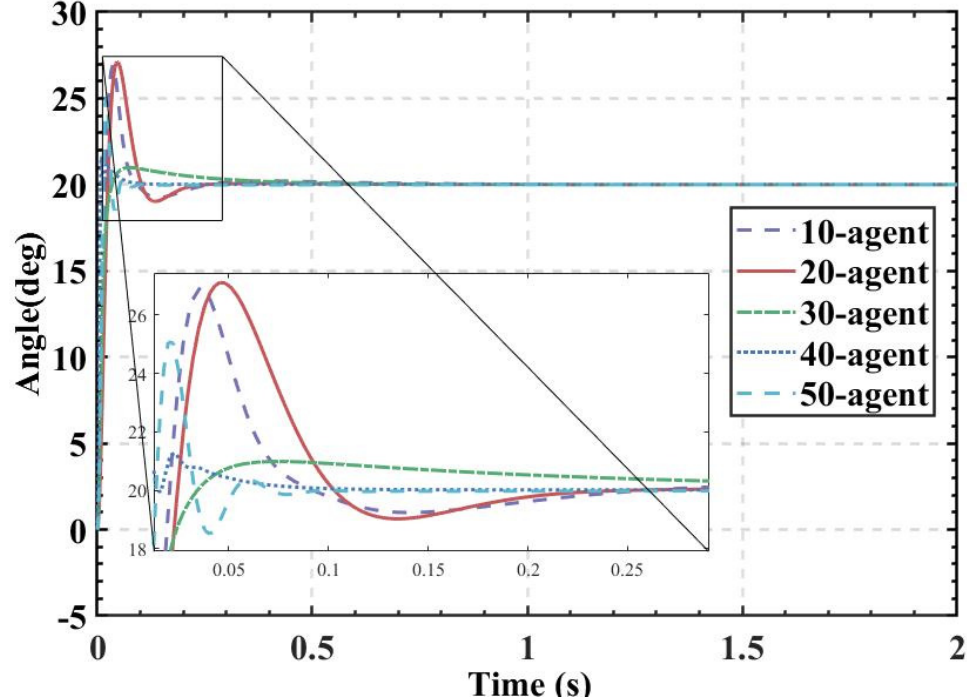
Figure 11. The actual angle of the balancing robot under PSO-PID algorithm.